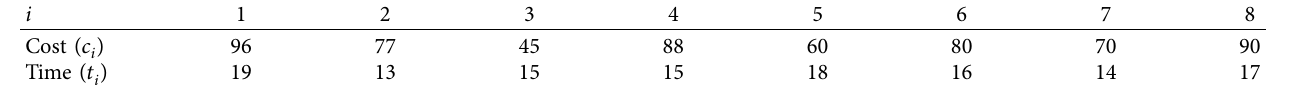
Table 6: The unit cost and time of every service procedures.